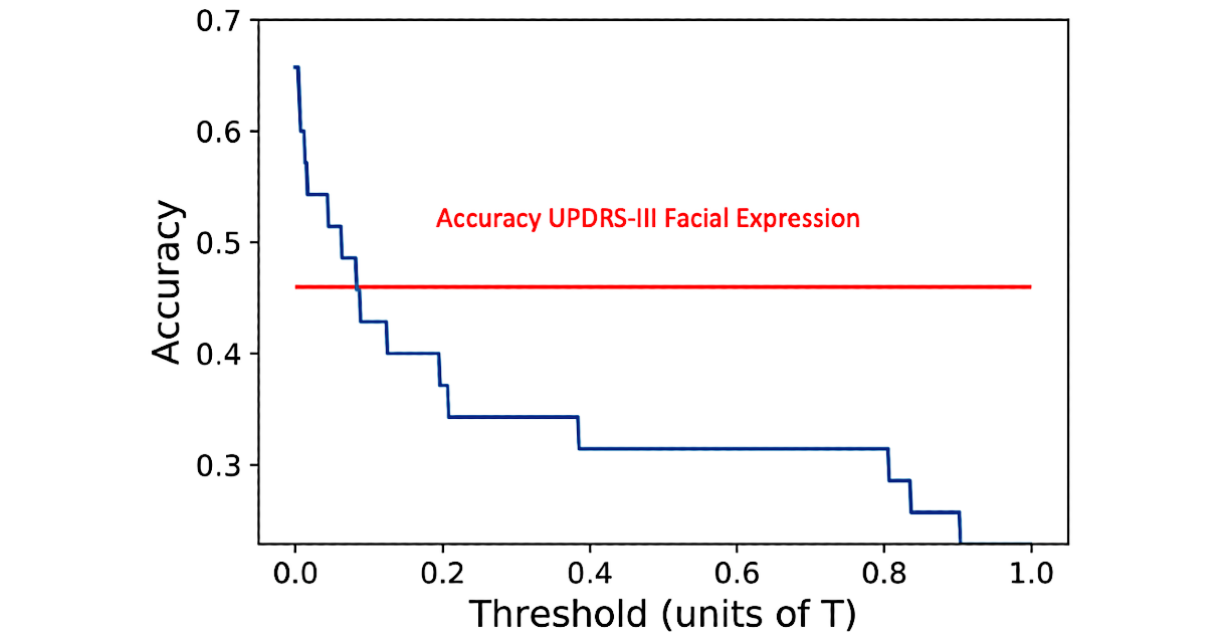
Figure 5. On-off sensitivity of the Tufts data set. On-off classification for a clinical visit is displayed as a function of threshold. On-off differences are far more subtle than PD versus Control differences (on which the model was originally trained). The red line shows the percentage of participants for which the neurologists rated the UPDRS-III Facial Expression score higher in the off state than in the on state. PD: Parkinson disease; UPDRS: United Parkinson Disease Rating